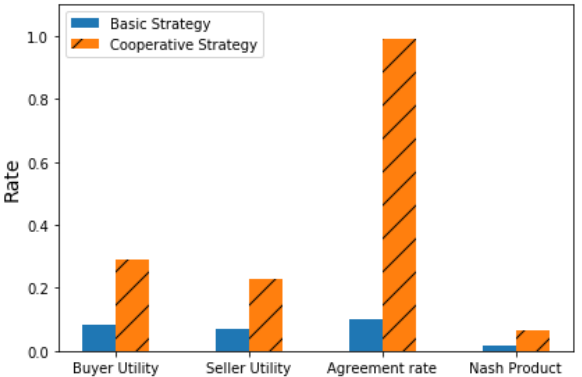
Figure 4. The overlap between the reservation intervals of agents is small.